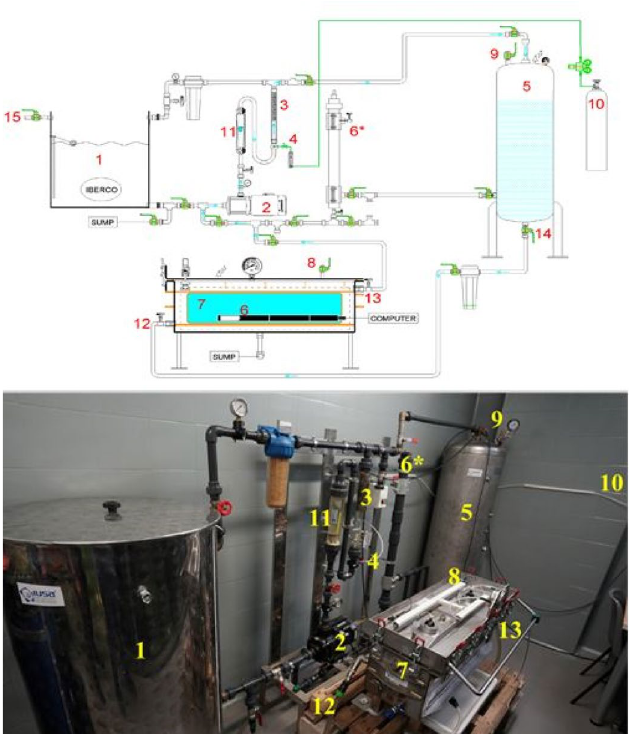
Figure 2. Supersaturated water production system components. (1) Open vessel. (2) Motor pump. (3) Dissolution tube. (4) Synthetic air injection valve. (5) Pressurized tank. (6) TDG and temperature sensor. (6*) TDG and temperature sensor inside the open circuit. (7) Pressurized aquarium. (8) Pressurized aquarium vent valve. (9) Pressurized tank vent valve. (10) Synthetic air bottle. (11) Flow meter. (12) Pressurized aquarium inlet